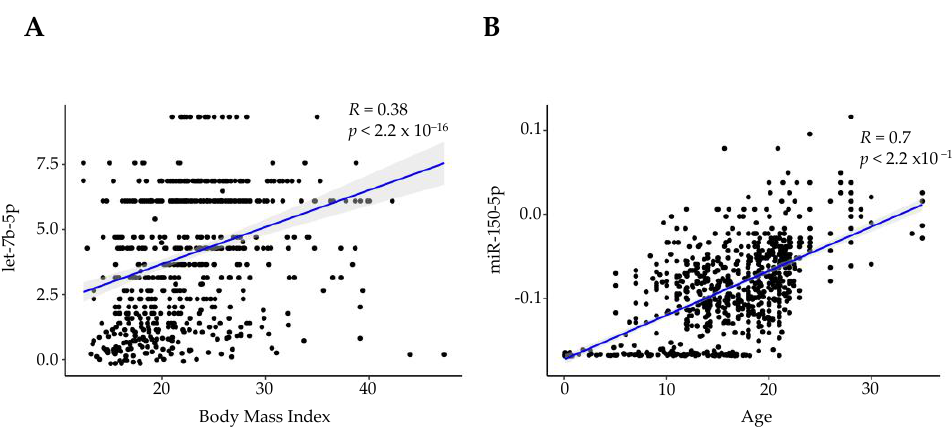
Figure 6. Top salivary miRNAs that correlate with participant BMI and age. Spearman rank correla- tions between top saliva miRNAs and BMI ( A ) and age ( B ).